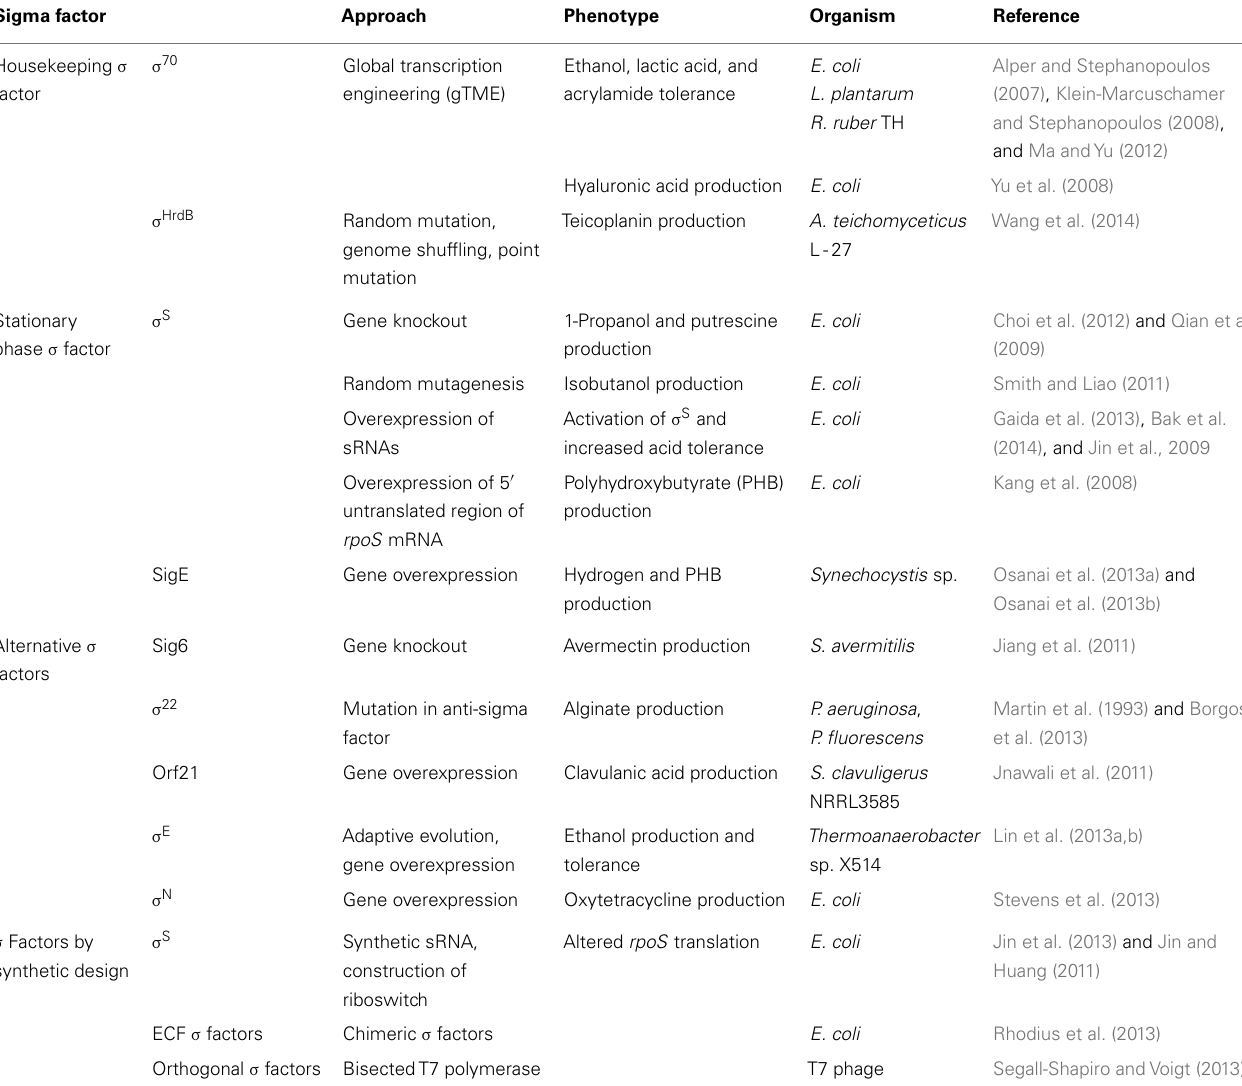
Table 1 |Various σ factor based engineering approaches applied for strain engineering